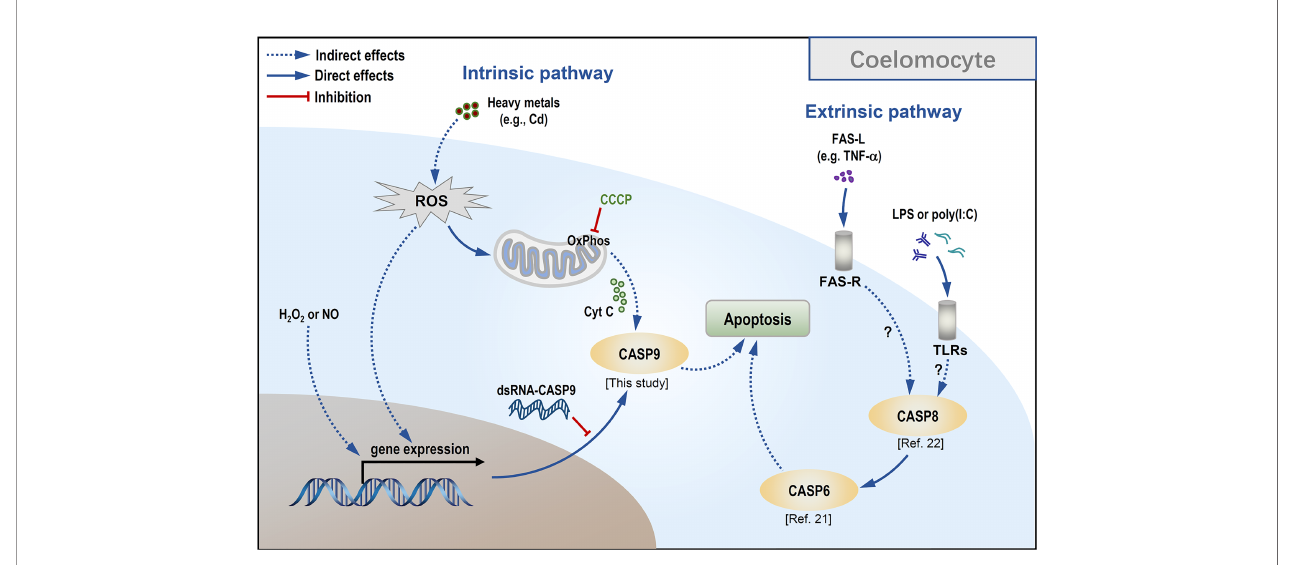
FIGURE 7 | Conceptualization of Cd-induced mitochondria-dependent apoptosis in sea cucumber